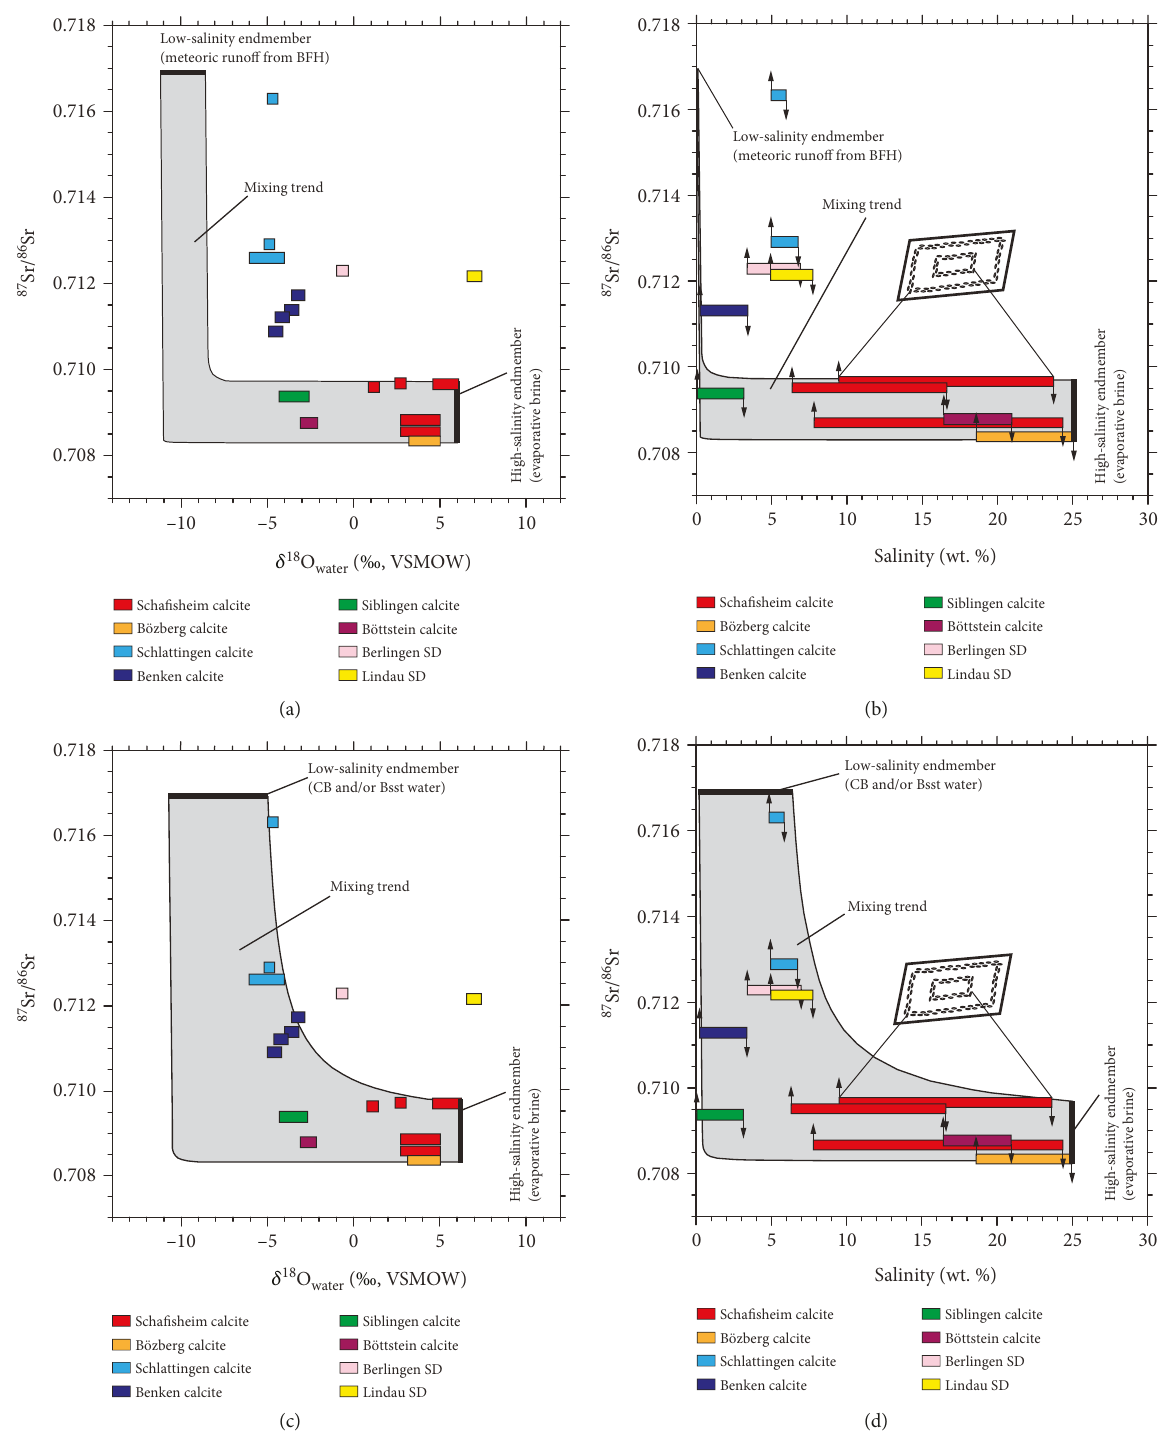
Figure 15: (a, c) Calculated δ 18 O signatures of calcite and saddle dolomite parent-waters and (b, d) fl uid inclusion salinities plotted against corresponding strontium isotope ratios of the secondary calcite and saddle dolomite (SD) in the Muschelkalk. The ranges in fl uid inclusion salinity re fl ect di ff erent generations of primary fl uid inclusions, whereas the strontium isotope ratio re fl ects a bulk value. Accordingly, the values at the high salinity end of the horizontal bars are likely to show lower strontium isotope ratios than the values at the low salinity end of the bars (black arrows). The grey areas represent mixing trends calculated for two in fi ltration scenarios outlined in Section 2.3 and 5.: (a, b) recharge of meteoric runo ff in the Black Forest Highlands (BFH) and lateral in fi ltration of the Muschelkalk in the Swiss Molasse Basin and (c, d) in fi ltration of deep groundwater from the Buntsandstein (Bsst) and/or the crystalline basement (CB) via fl uid ascent along faults or fractures (Figure